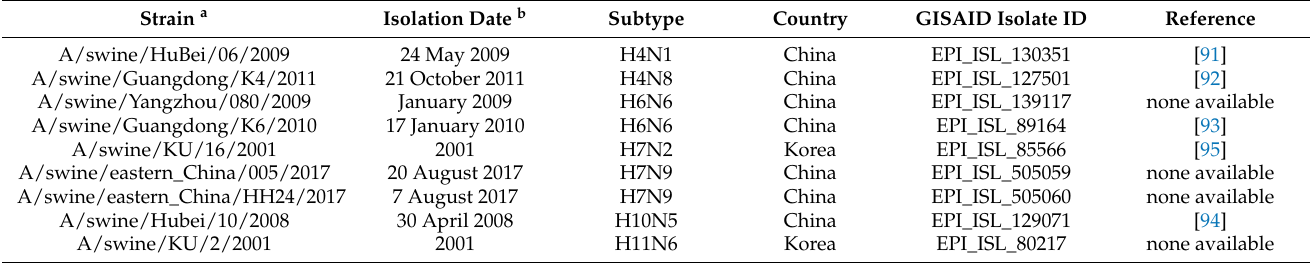
Table 4. IAVs-S of subtypes other than H1, H3, H5, and H9 subtypes isolated in Asian